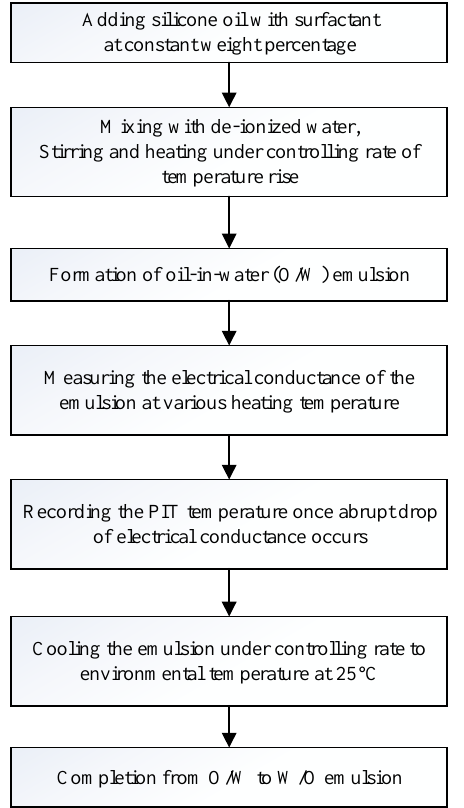
Figure 1. Experimental procedures of phase change from O/W to W/O emulsion using the PIT method.